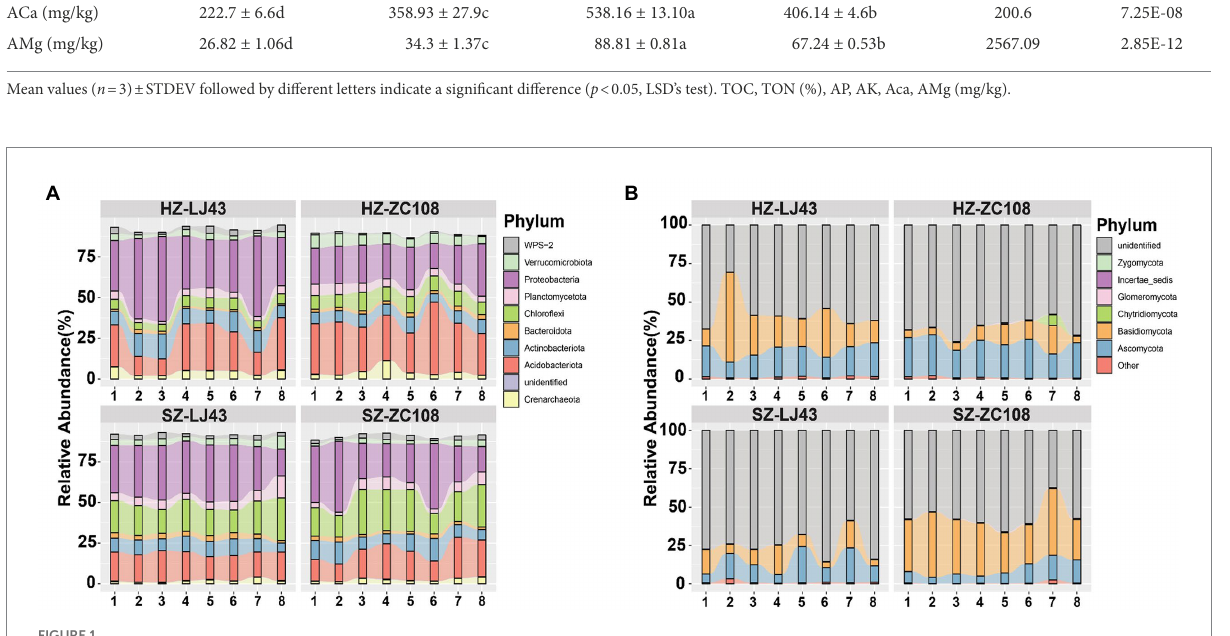
FIGURE 1 The composition of rhizosphere microbial communities of two tea varieties in different locations. Phylum distribution of the OTUs. (A) Top 10 bacterial phyla abundances in rhizosphere soil of HZ-LJ43, HZ-ZC108, SZ-LJ43, and SZ-ZC108. (B) Top 10 fungal phyla abundances in rhizosphere soil of HZ-LJ43, HZ-ZC108, SZ-LJ43, and SZ-ZC108. Mean values ± standard error ( n = 8); different letters indicate a significant difference ( p < 0.05) based on one-way ANOVA followed by an LSD